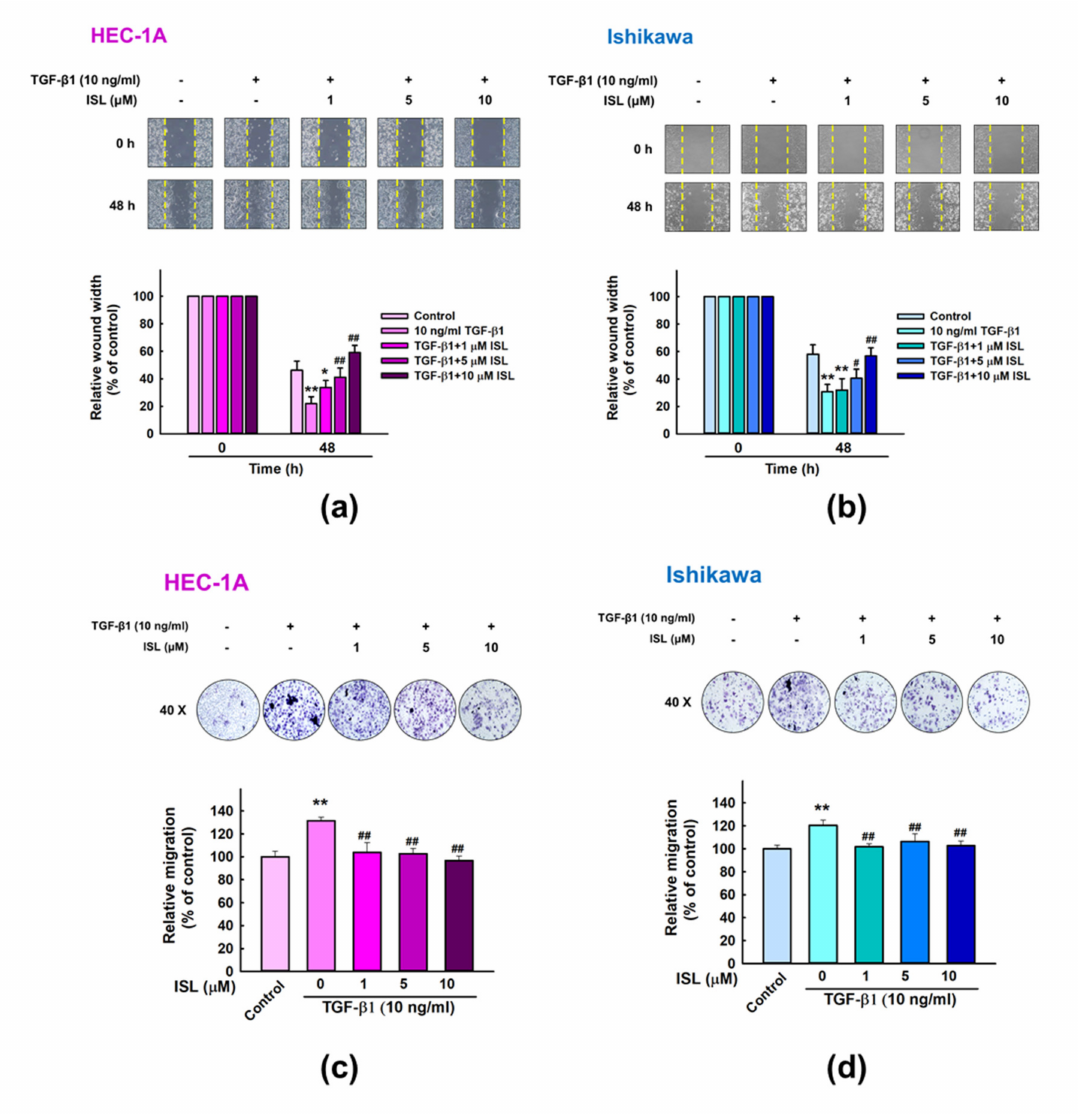
Figure 2. ISL inhibits TGF- β 1-induced migration of human endometrial cancer cells. ( a , b ) The motility response of HEC-1A and Ishikawa cells to the administration of TGF- β 1 (10 ng/mL) and ISL (1, 5, and 10 µ M) were measured using the wound- healing assay. Images were captured at 0 and 48 h (100 × magnification). ( c , d ) ISL (1, 5, and 10 µ M) inhibits TGF- β 1-induced migration of HEC-1A and Ishikawa cells, as confirmed by the transwell migration assay. Images were captured at 48 h (400 × magnification). The quantitative values were expressed as the mean ± SD. * p < 0.05, ** p < 0.01 compared to the vehicle control. # p < 0.05, ## p < 0.01 compared to the TGF- β 1 alone